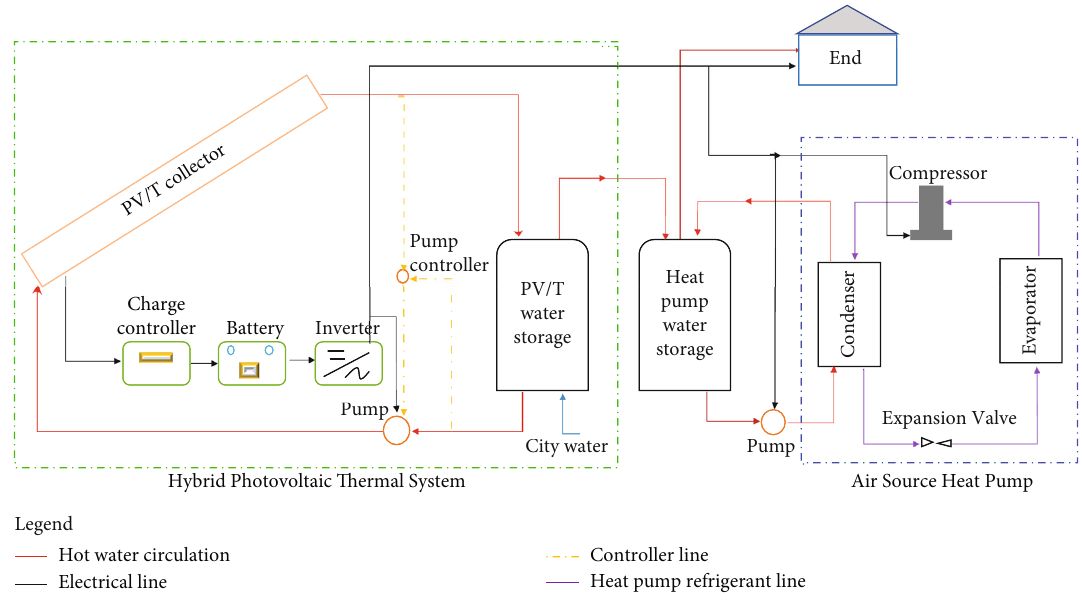
Figure 1: Schematic diagram of hybrid photovoltaic thermal heat pump